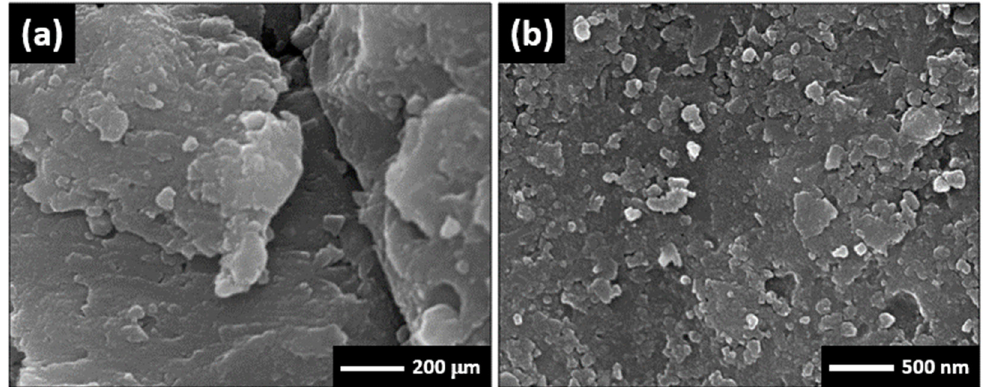
Figure 1. SEM of the surface morphology for the milled nanocomposites using Route 3 at different magnifications, ( a ) 200 μ m, and ( b ) 500 nm. magnifications, ( a ) 200 µ m, and ( b ) 500